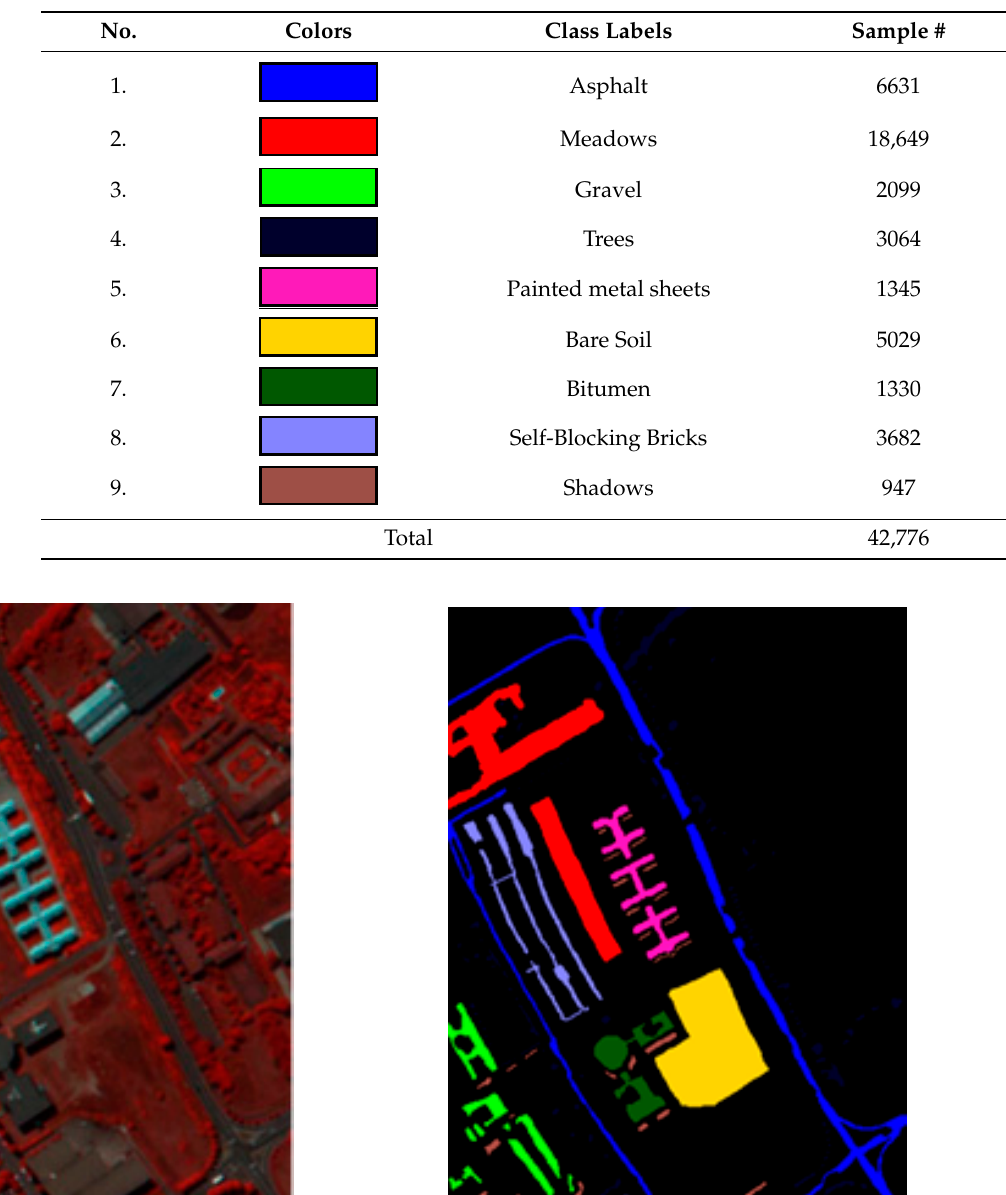
Figure 4. The analysis for the training data in dataset Salinas: ( a ) The overlapping degrees of various values α , ( b ) The visualized training sample distribution of PCA and 𝑟 = 0.41 , ( c ) The visualized training sample distribution of value 𝛼 = 0 and 𝑟 = 0.34 , ( d ) The visualized training sample distribution of value 𝛼 = 0.95 and 𝑟 = 0.18 , and ( e ) The visualized training sample distribution of value 𝛼 = 1 and 𝑟 = 0.07 . Table 5. Numbers of pixels on dataset Pavia University. Table 3. Pixel numbers of dataset Salinas.